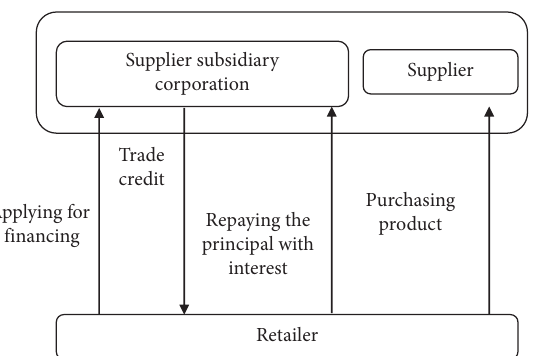
Figure 1: Dual-channel supply chain financing and trading process.